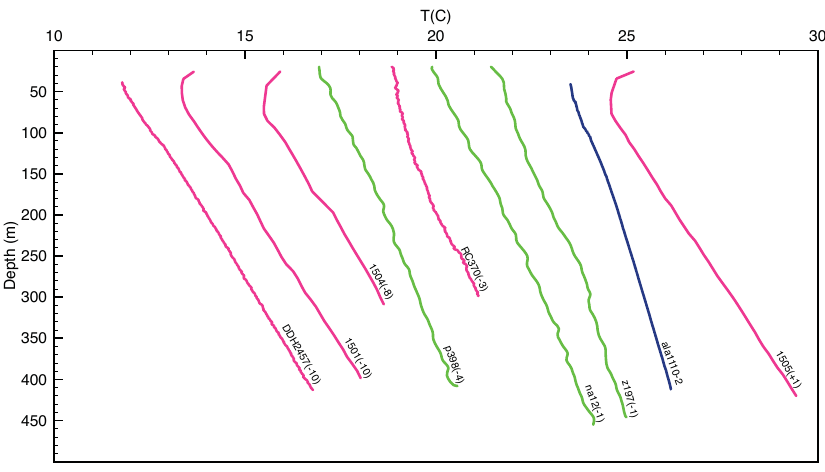
Figure 3. Retained temperature–depth profiles measured in 1994 (green), 2012 (blue), and 2015 (pink). Temperature scale is shifted as indicated in parentheses. The profiles from Michilla measured with DTS (in green) appear to be noisier than those obtained from conventional